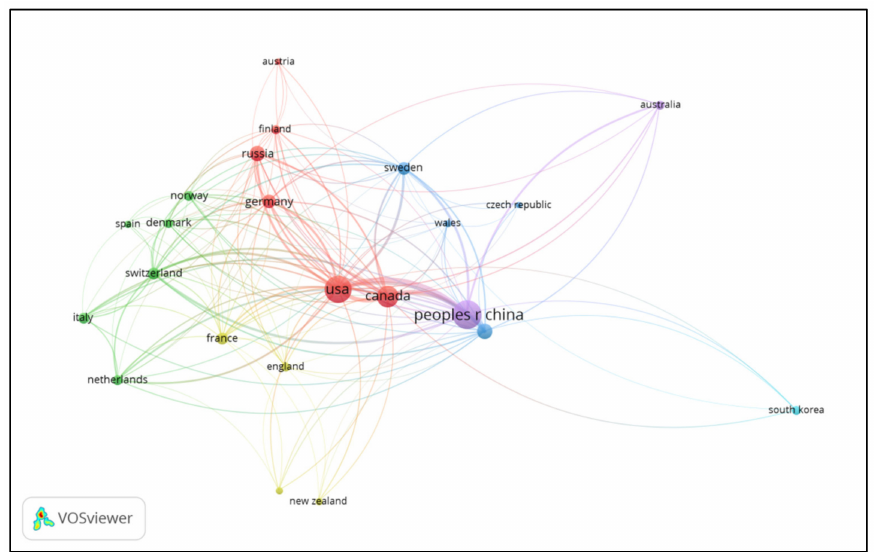
Figure 3. The citation network of 23 countries with minimum five publications (VOSviewer 1.6.15). The size of the circle and font in the map depend on the degree of nodes, the strength of links, and the amount of citations. The color of the circle represented [sic] the cluster to which it belonged, and the cluster was represented [sic] by different colors.